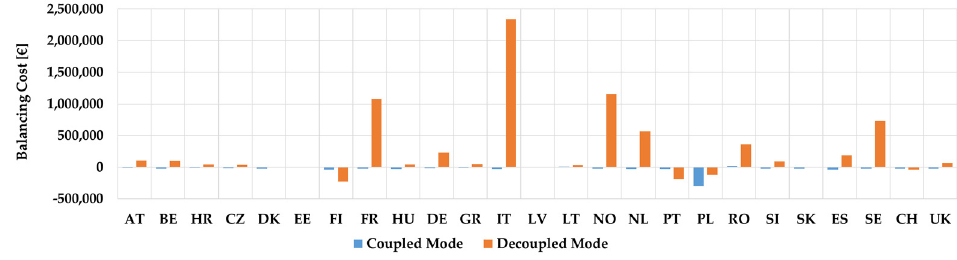
Figure 9. Balancing cost incurred in each participating control area.